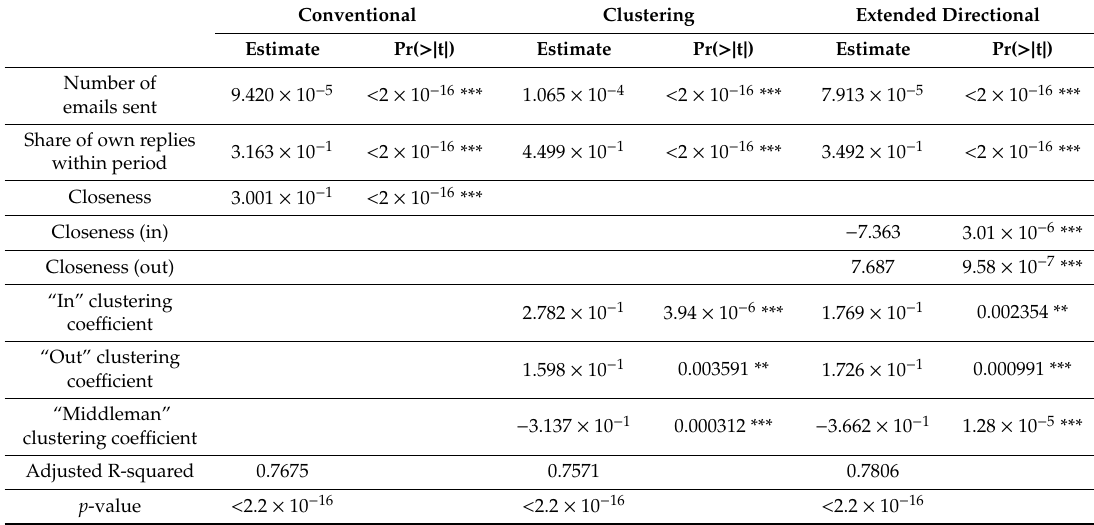
Table 8. One-day